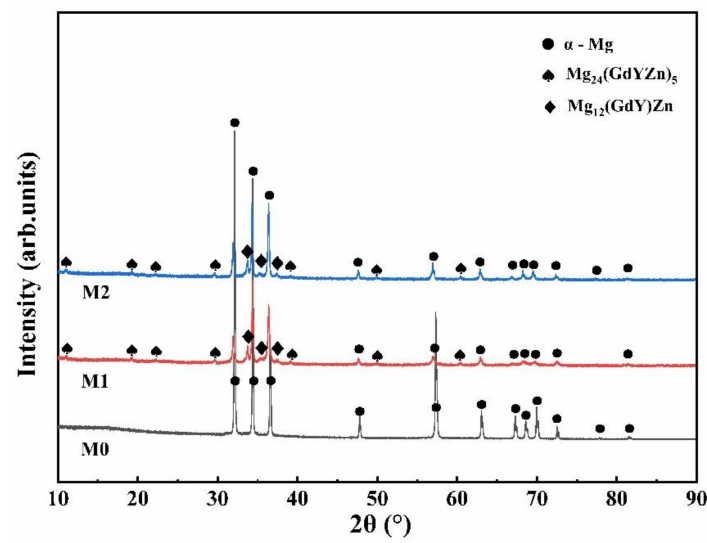
Figure 1. XRD patterns of all fabricated materials.